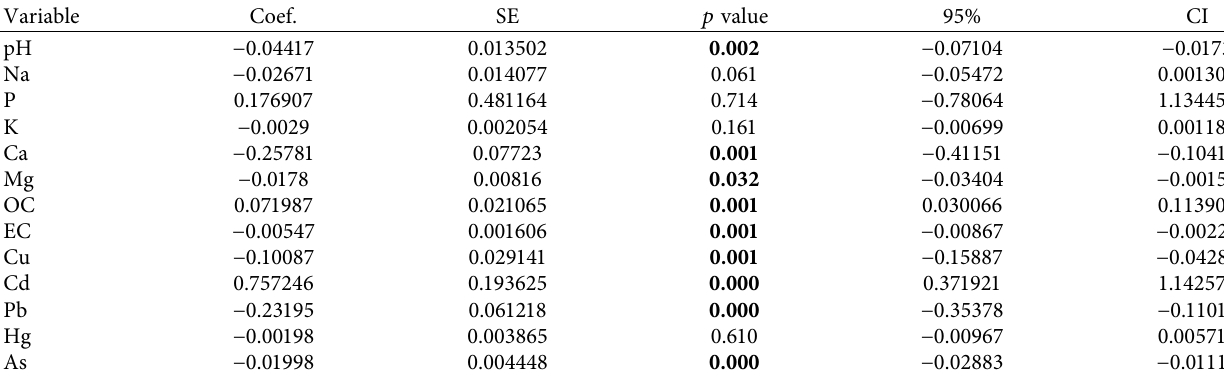
Table 8: Influence of fallow years of mined land on soil